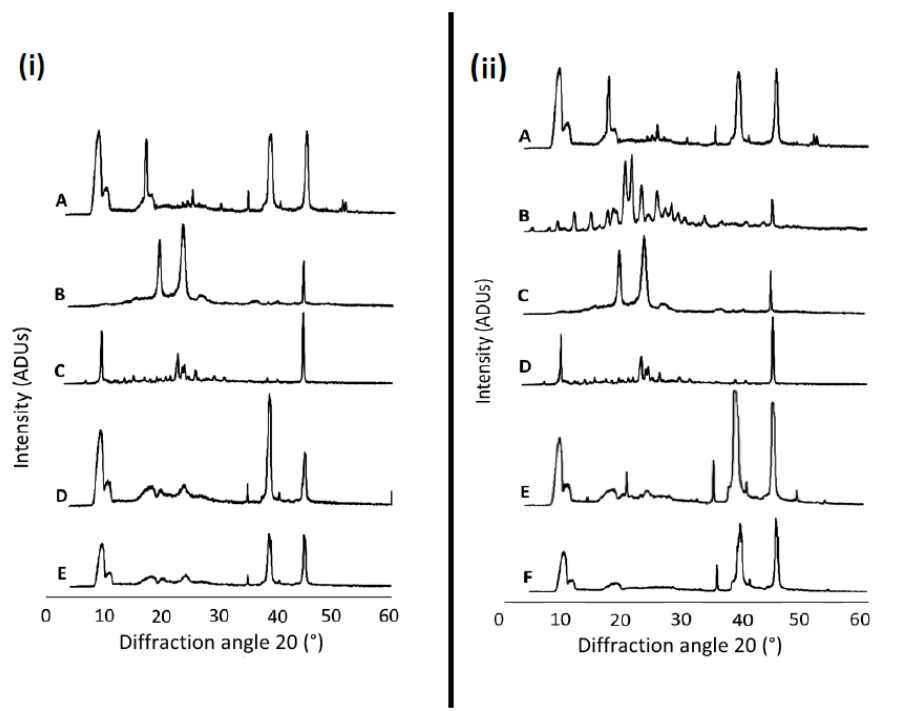
Figure 1. ( i ) P68+DQA HT. XRD spectra for ( A ) HT, ( B ) P68, ( C ) DQA, ( D ) P68, DQA and HT in a physical mixture (using the same ratio as the nanoformulation), ( E ) P68+DQA HT (lyophilized nanoformulation). ( ii ) P68+DQA HT+DFO. XRD spectra for ( A ) HT, ( B ) DFO, ( C ) P68, ( D ) DQA, ( E ) P68, DQA and HT in a physical mixture (using the same ratio as the nanoformulation), ( F ) P68+DQA HT+DFO (lyophilized nanoformulation). The P68, DQA, and DFO spectra are as previ-